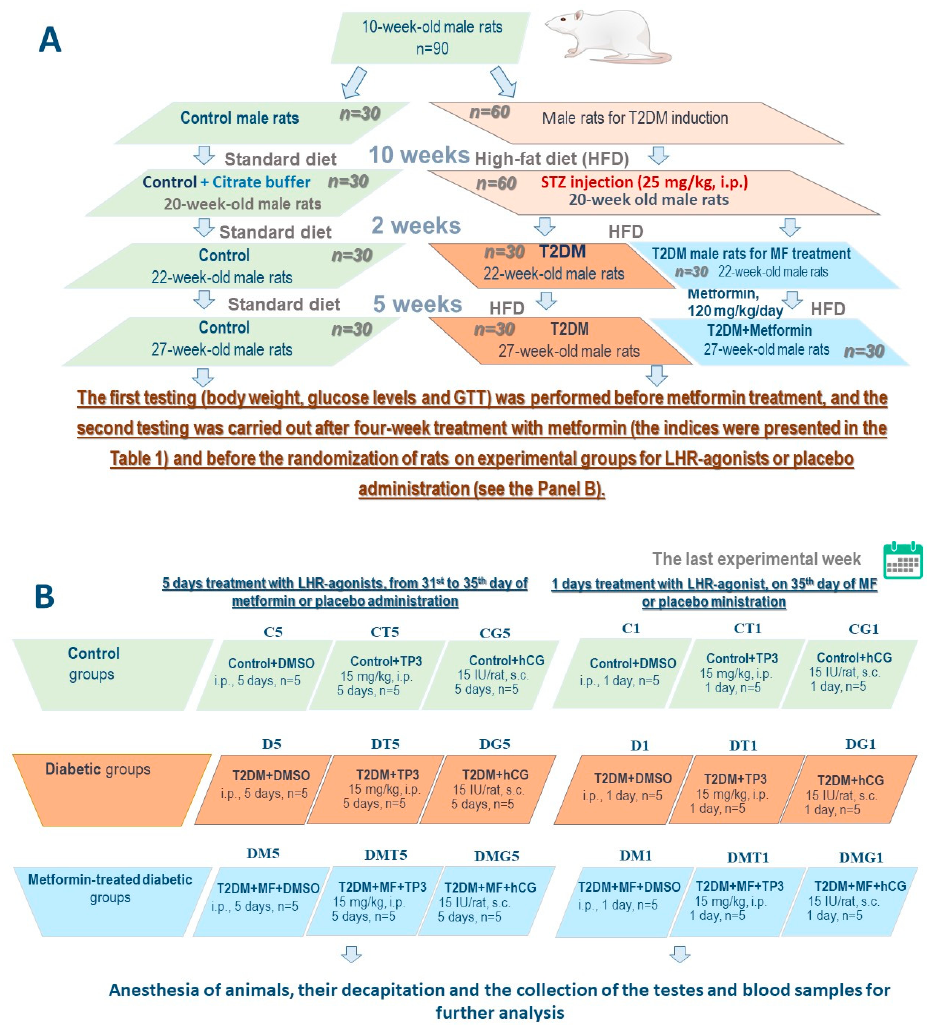
Figure 10. The design of experiments ( A ) and the rat groups ( B